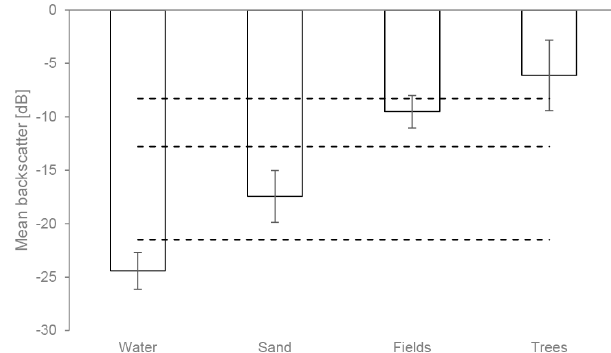
Figure 5. Average backscatter for four land cover classes for a sam- pling duration of 1 month and a 3 × 3 boxcar filter. Bars indicate the mean ± 2standard deviations. Horizontal lines indicate the thresh- olds between the respective